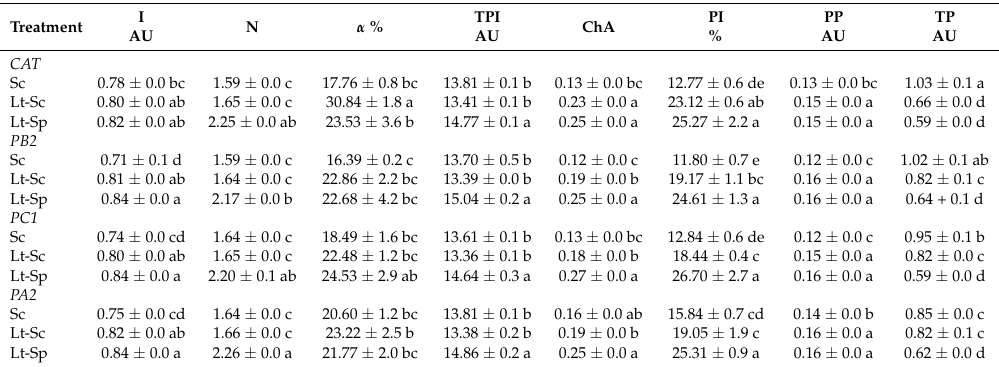
Table 5. Results from UV-Vis determination of colour parameters and polyphenols. The statistical analysis is given by parameter (columns) and the difference in letters indicates significant statistical difference (LSD method with 95% confidence level). Means ± STD ( n = 3).